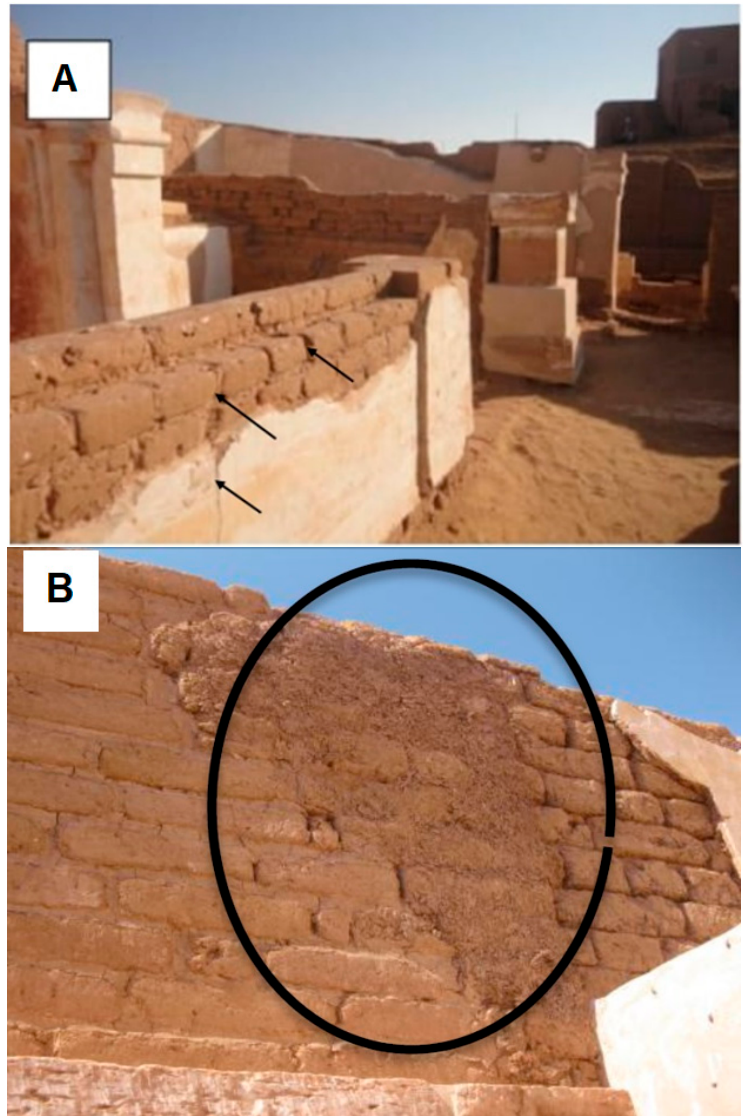
Figure 1. Bir Al-Shaghala Cemetery views and damage caused by termite attack. ( A ) damage occurred in the binding materials of mudbricks; ( B ) damage to the surface walls and shelter tubes of termites over the mudbricks.